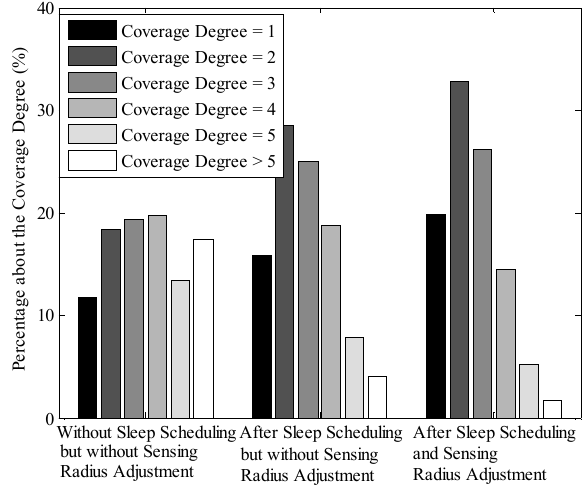
Figure 18. Percentage about the coverage degree (100 m × 100 m, 200 nodes).